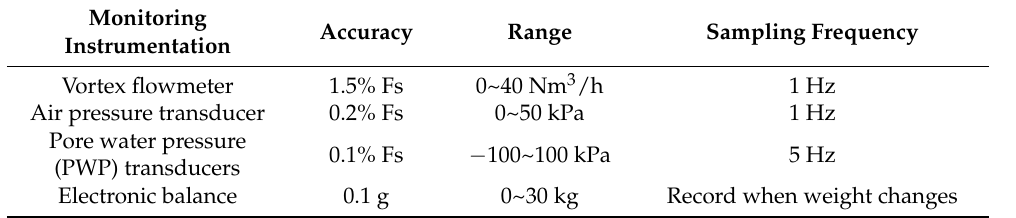
Table 2. Parameters of the monitoring transducers.